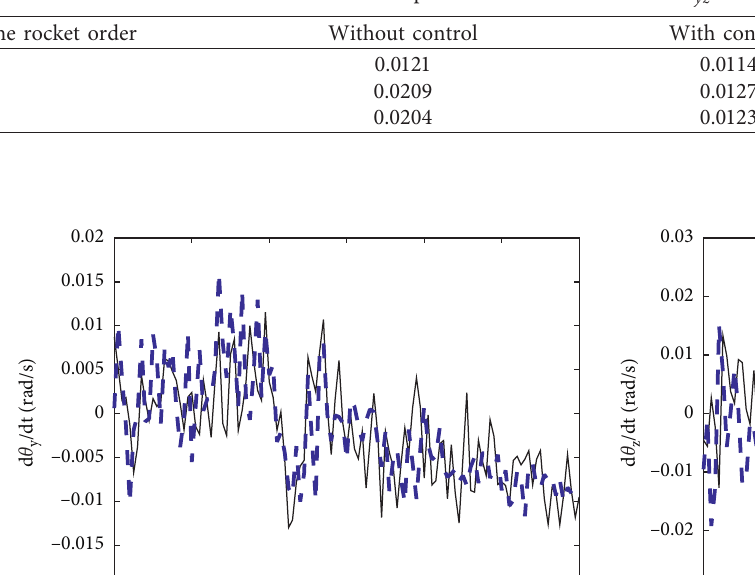
Table 4: Comparison of the RMS value of _ θ